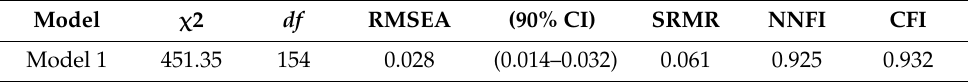
Table 4. Confirmatory factor analyses hypothesized—goodness of fit